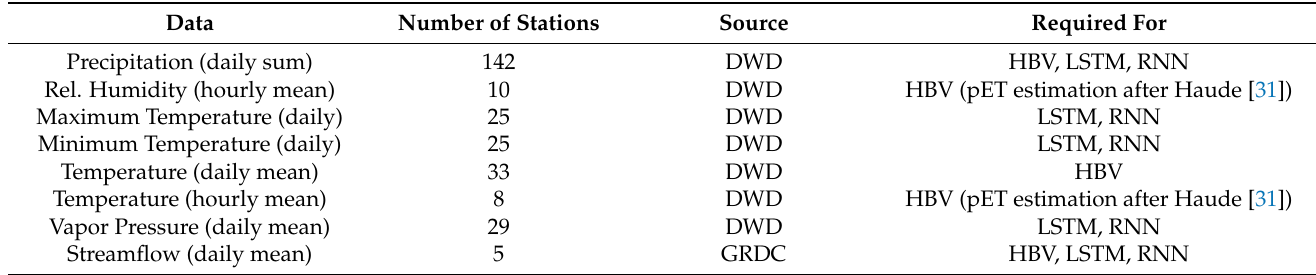
Table 1. Number and data source of hydro–climatic stations used to derive forcing data for the models and to calculate the potential